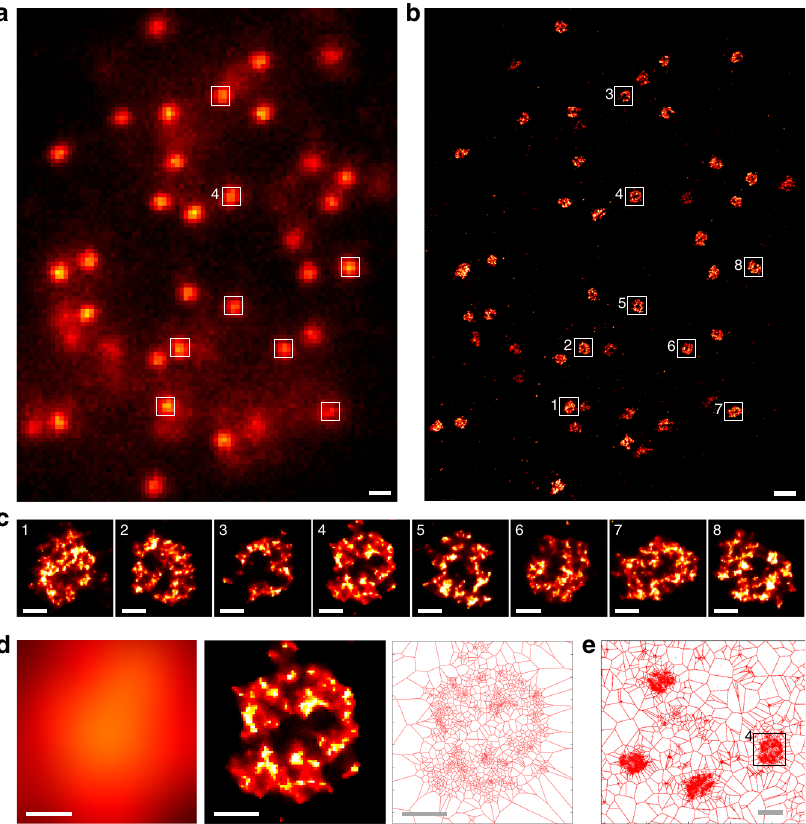
Fig. 1 SMLM images of centromeres in a non-synchronized U2OS cell. a Conventional epi fl uorescence image of CENP-A. b High-resolution SMLM image of the same region revealing that CENP-A in fact forms characteristic clusters. c Zoomed view of several centromeres from this cell. d Cluster #4 imaged in classical epi fl uorescence microscopy (left), SMLM (center) and represented as a Voronoi diagram built on localizations of fl uorophores (right). e Larger region of the Voronoi diagram containing cluster #4 and other clusters. A signi fi cant portion of the non-synchronized cells have centromeres of this rosette-like shape, suggesting that they are formed in a particular phase of the cell cycle. Scale bars, 500 nm ( a , b , e ) and 100 nm ( c , d ); for similar experiments in HeLa cells see Supplementary Figs. 1 and